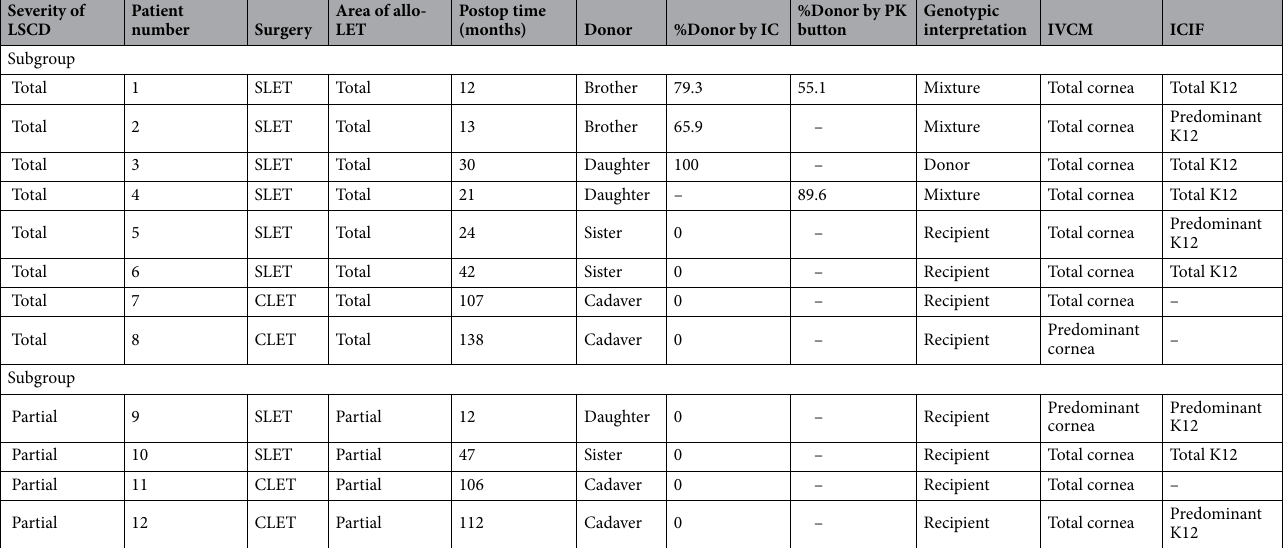
Table 2. Genotypic profiles and patient results after Allo-LET. Postop time, postoperative time at the genotypic analysis.